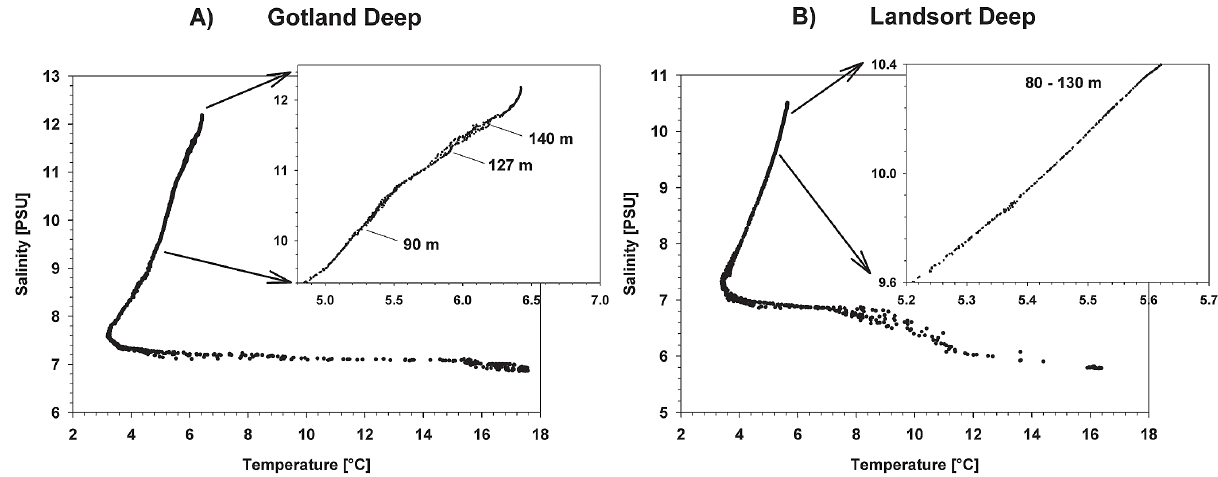
Fig. 6. Temperature–salinity diagrams. The inserts denote the depth interval where the redox zone is